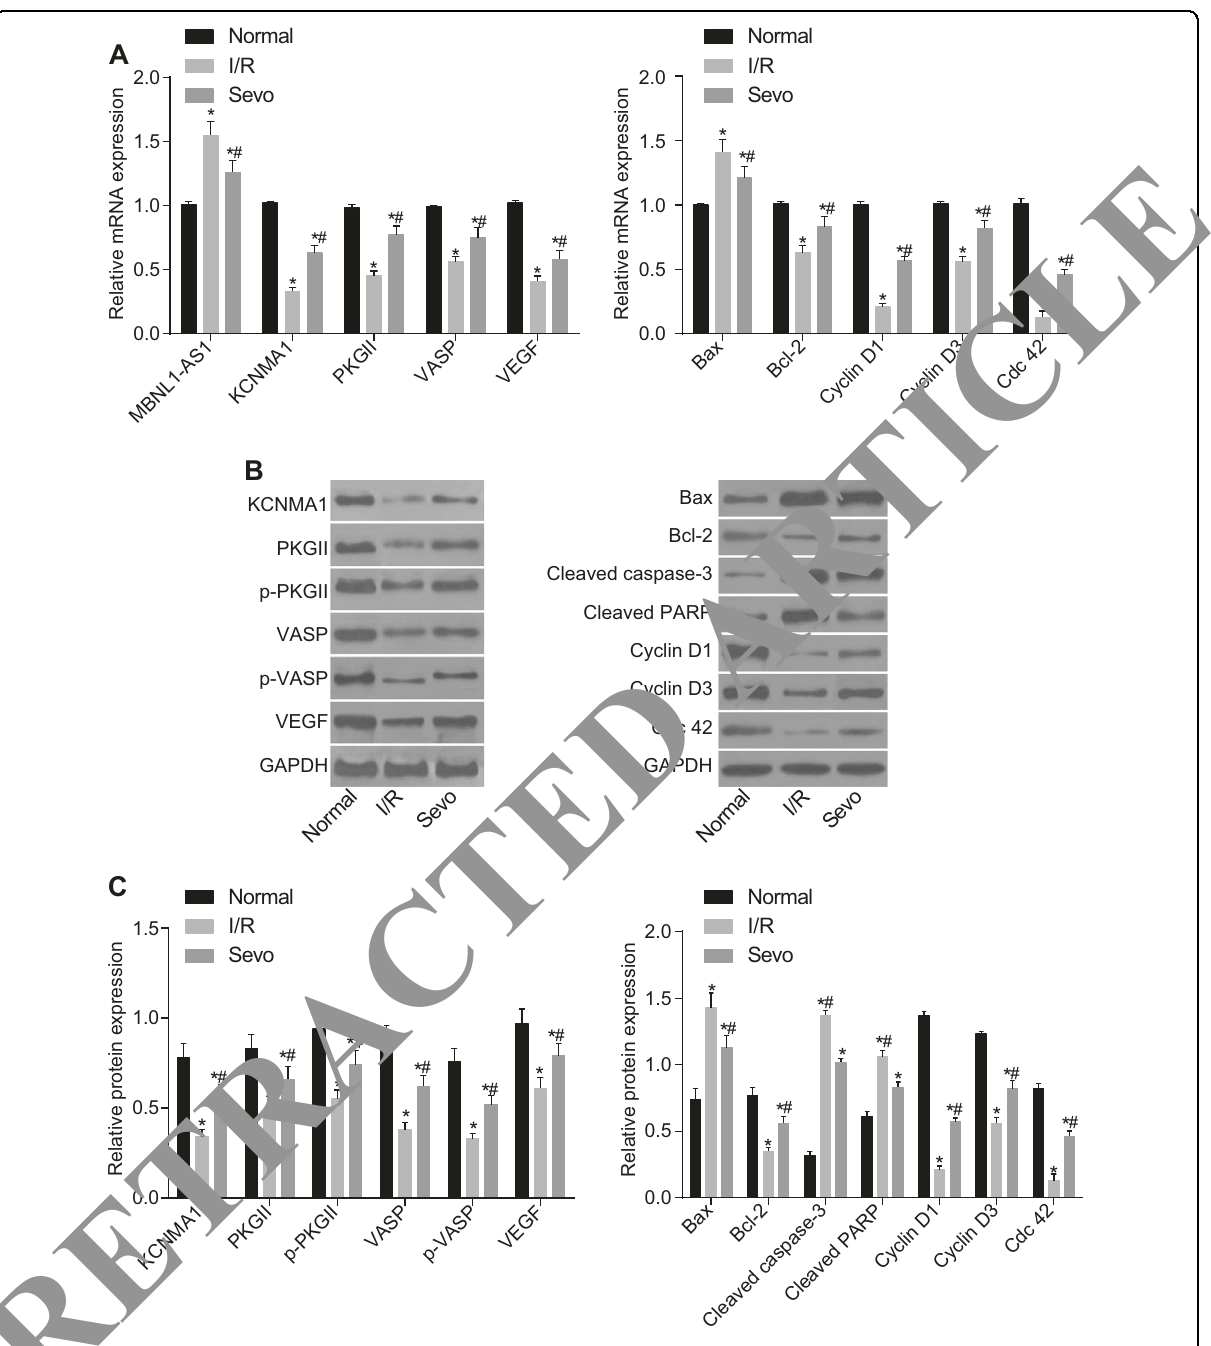
Fig. 4 MBNL1-AS1 was highly expressed, but KCNMA1 and cGMP-PKG pathway-related factors were poorly expressed in mice with I/R injury after TKA. a Relative mRNA expression of MBNL1-AS1, KCNMA1, PKGII, VASP, VEGF, Bax, and Bcl-2 in the skeletal muscle tissues of mice detected by RT-qPCR. b Protein bands observed after Western blot analysis. c Relative protein levels of KCNMA1, PKGII, VASP, p-PKGII, p-VASP, VEGF, Bax, and Bcl-2 in skeletal muscle tissues of mice evaluated by Western blot analysis. I/R ischemia-reperfusion, Sevo sevo fl urane, MBNL1-AS1 muscleblind-like 1 antisense RNA 1, KCNMA1 potassium calcium-activated channel subfamily alpha 1, PKGII type II cyclic guanosine monophosphate- dependent protein kinase G, VASP vasodilator-stimulated phosphoprotein, VEGF vascular endothelial growth factor, Bcl-2 B-cell lymphoma/leukemia- 2, Bax Bcl-2 associated X protein, GAPDH glyceraldehyde-3-phosphate dehydrogenase; * p < 0.05 vs. the normal group; # p < 0.05 vs. the I/R group; n = 10; measurement data are expressed as the mean ± standard deviation. Comparisons among multiple groups were performed by one-way ANOVA; the experiment was repeated 3 times